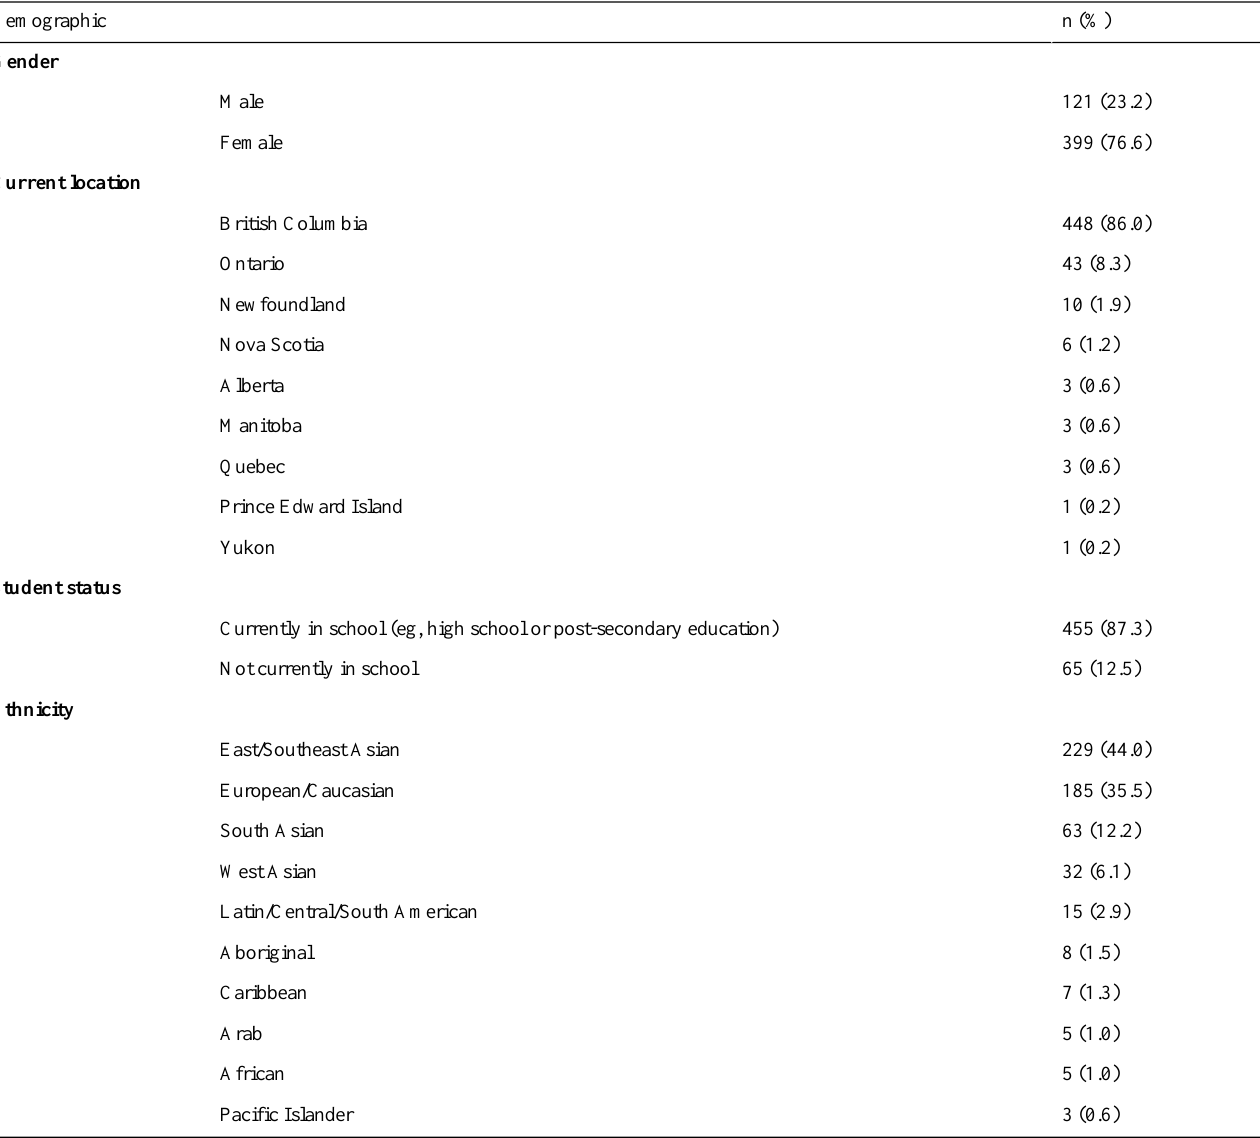
Table 1. Participant demographics